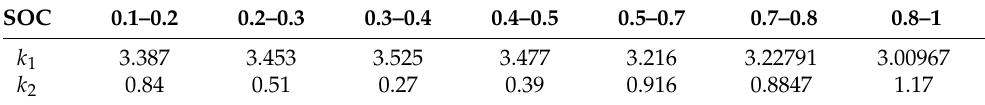
Table 1. The fitting parameter values corresponding to the piecewise linear graph of